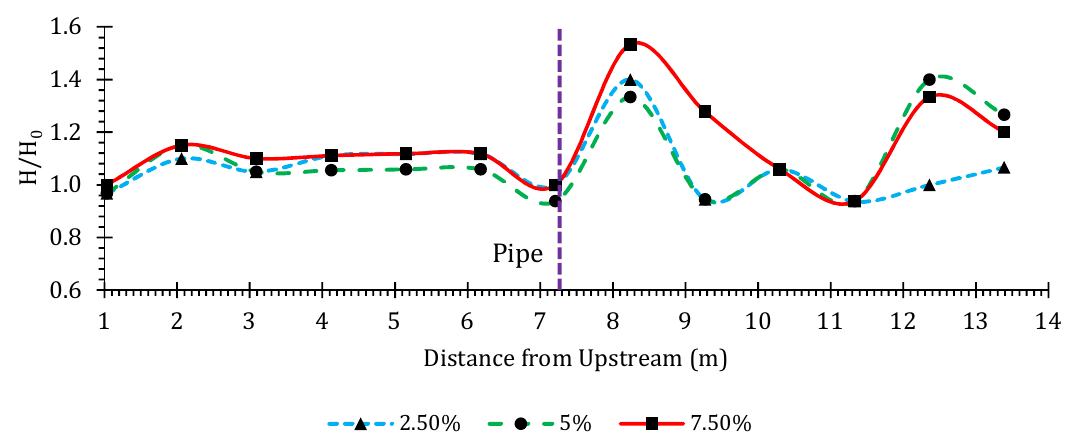
Figure A41. Water height ratios in a 45 ◦ junction for Fr = 2.80 in the narrow Figure A41. Water height ratios in a 45° junction for Fr = 2.80 in the narrow channel. Figure A41. Water height ratios in a 45° junction for Fr = 2.80 in the narrow channel. Figure A41. Water height ratios in a 45° junction for Fr = 2.80 in the narrow channel.